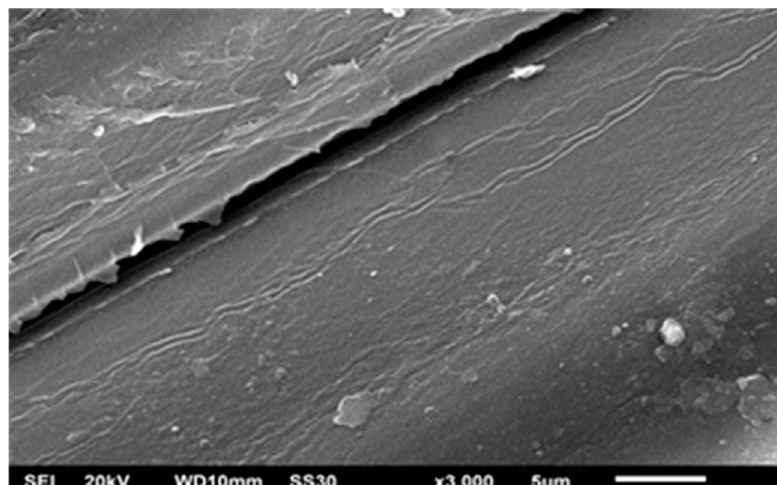
Figure 17. Surface morphology of uncoated bamboo.